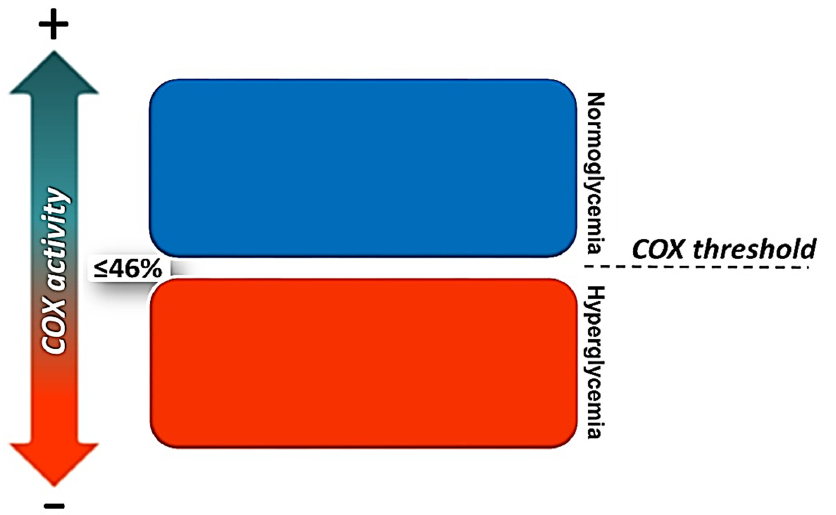
Figure 11. The islet-COX activity threshold. In CDs rats, islet-COX activity of ≥ 46% is mandatory to maintain normoglycemia [10].